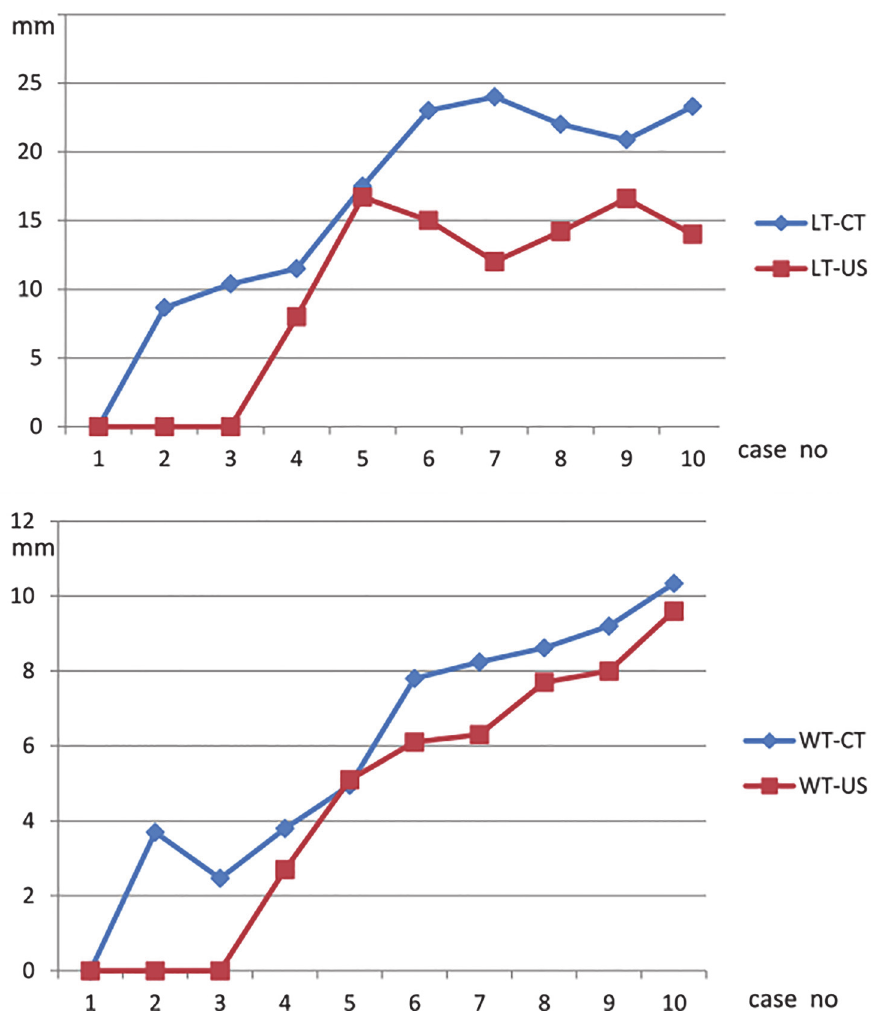
Fig 3. Validation for nodal length values measured by ultrasound (LT-US) with computed tomography (LT-CT). Validation for nodal width values measured by ultrasound (WT-US) with computed tomography